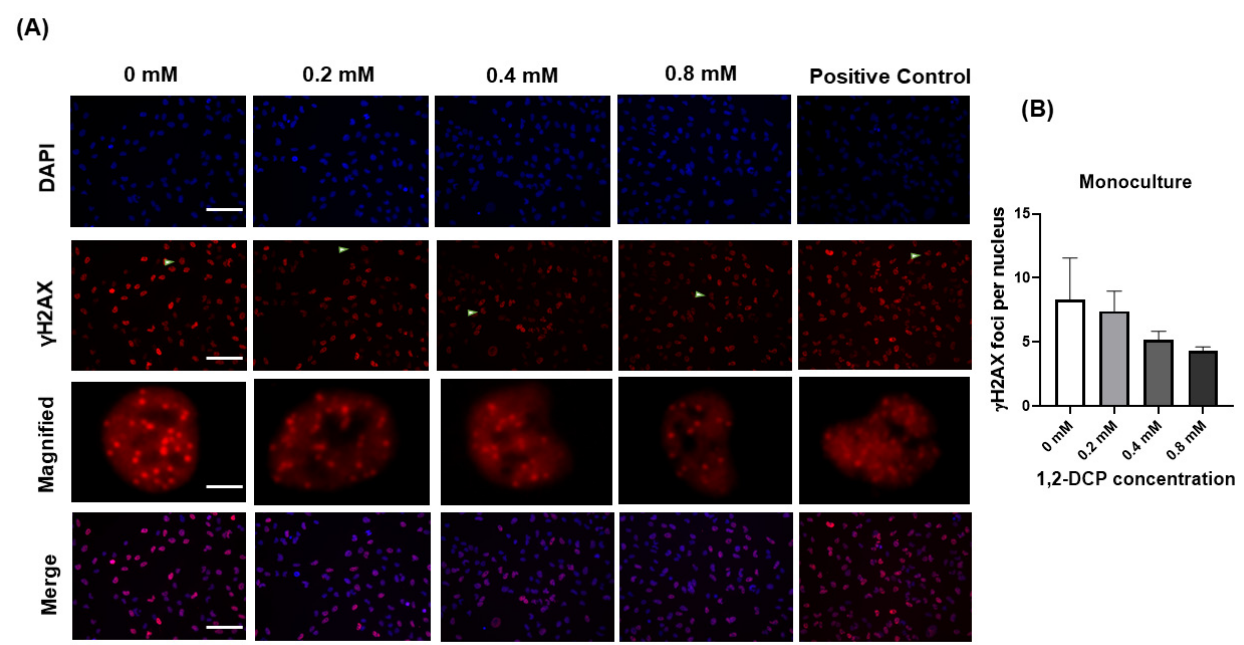
Figure 4. Effects of 1,2-DCP on DNA in monocultured MMNK-1 cholangiocytes, as assessed by γ H2AX immunocytochemistry. Monocultured MMNK-1 cholangiocytes were exposed to 1,2-DCP at 0, 0.2, 0.4, and 0.8 mM for 24 h. For positive control, MMNK-1 cholangiocytes were exposed to 0.2 mM of H 2 O 2 for 2 h. Cells were fixed with 4% PFA, permeabilized with 0.2% Triton-X, blocked with 1% BSA in PBST, and incubated with primary anti- γ -H2AX antibody overnight, then with secondary antibody. Nuclei were stained with DAPI and observed under a fluorescence microscope. Scale bar: 100 µ m for all images except the magnified images (20 µ m). Arrowheads: magnified images. ( A ) Photomicrographs of γ H2AX immunostaining. ( B ) γ H2AX foci count per nucleus. Data are mean ± SD, n = 3. compared with the control group (0 mM), by one-way ANOVA followed by Dunnett’s multiple comparison test.